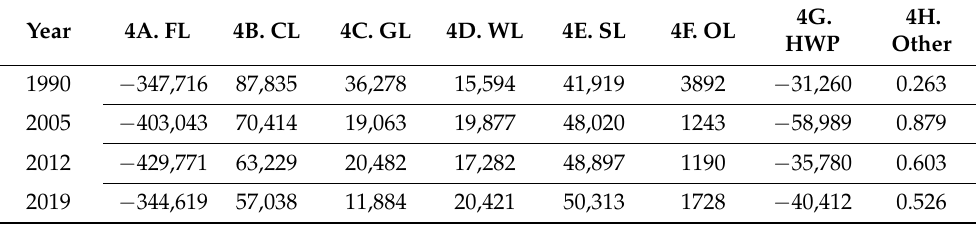
Table 2. GHG emissions/removals evolution, by type of land use categories, EU-27 + UK (kt CO 2 eq.). Year 4A.